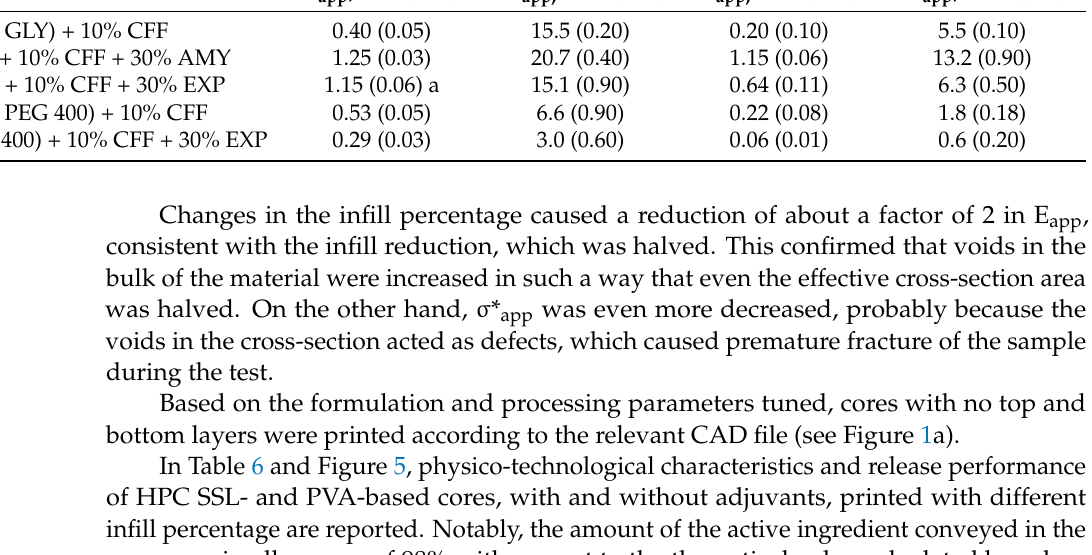
Table 5. E app and σ * app of 3D printed dumbbell specimens. Infill 100% Infill 50% Formulation